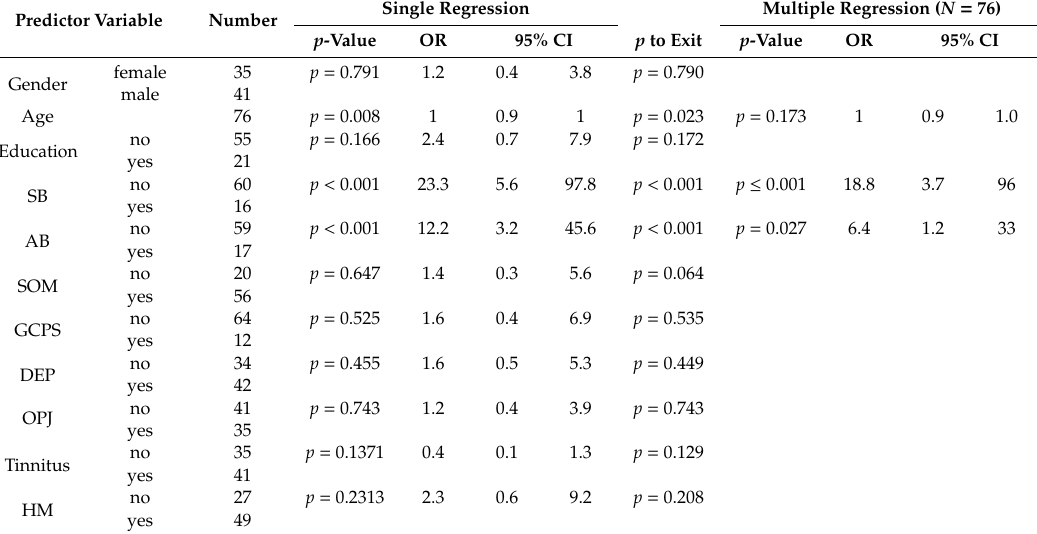
Table 3. Single and multiple logistic regression models for the prediction of mainly myogenous pain (MMP) and / or mainly arthogenous pain (MAP) in Lyme disease (LD) patients. For each single regression, the number of cases included in the analysis is shown. Associations are expressed as odds ratio (OR) and 95% confidence interval (CI). For each removed predictor variable, the p -to-Exit is